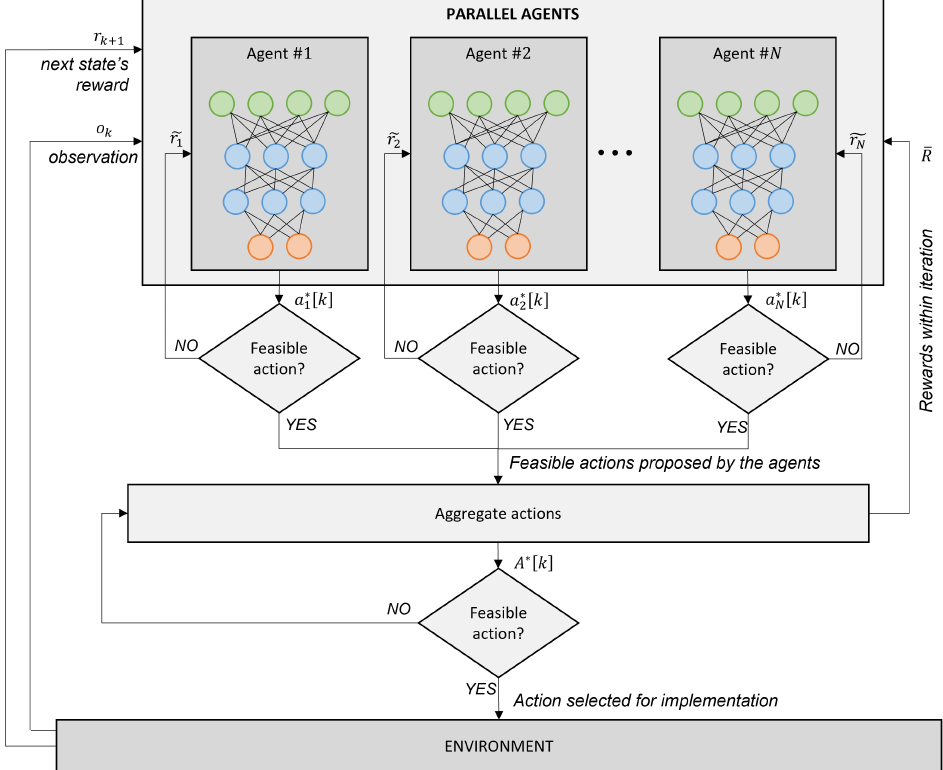
Figure 1. Parallel DRL with hard constraints’